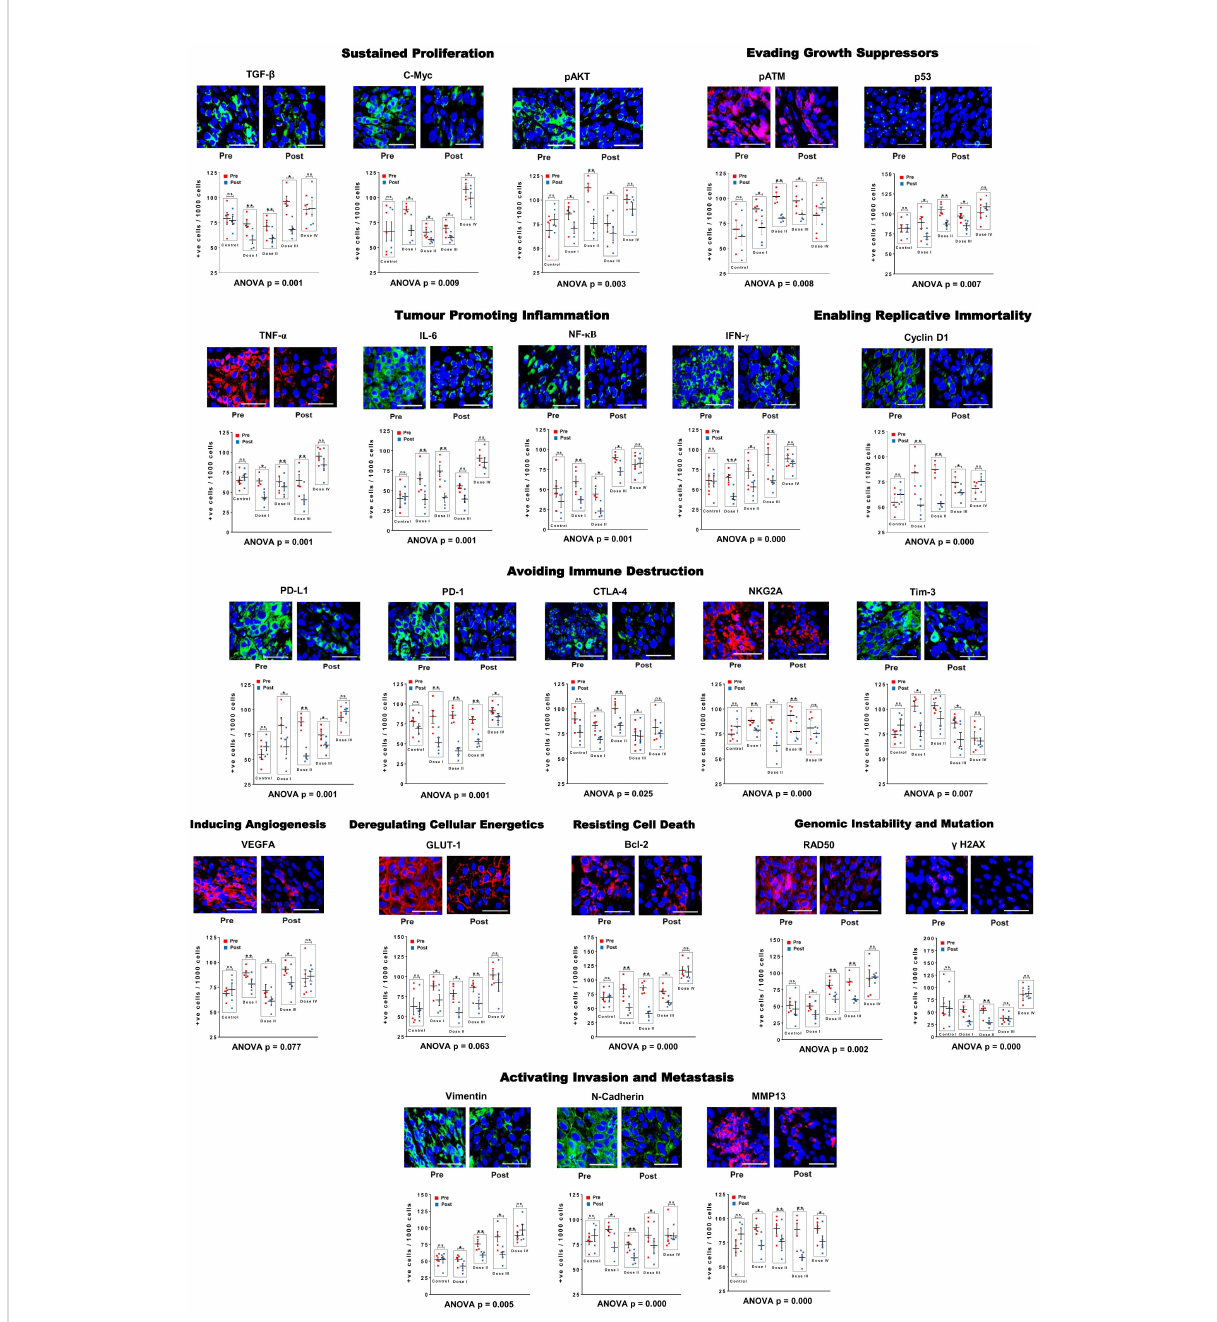
FIGURE 3 R-Cu treatment down-regulates cancer hallmark biomarkers, including fi ve immune check-points, in OSCC. Upper panels are representative IF images (scale bar 10µm); lower panels represent results of quantitative analysis of various biomarkers. One thousand cells were analysed in each case and the number of cells showing positive fl uorescent signals were recorded. Combined statistical comparison of pre versus post treatment values of all four treatment groups with the control group was done using two-way ANOVA; p values of which are given under each graph. Comparison of pre versus post treatment values within each treatment group was performed by paired Student ’ s t-test. Results are represented as mean ± SEM of tissue sections of 5 patients in each treatment group. *< p < 0.05; **< p < 0.01; ***< p < 0.001). ns, not signi fi